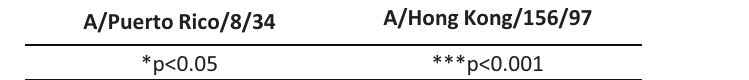
FIGURE 4 | Similar IgG1 titers found but different mFc γ RIII activation. Serum taken 1 day prior to influenza challenge were tested in ELISA for IgG1 binding to H1 FL HA A/Puerto Rico/8/34 (A) and for Fc γ RIII activation by H1 A/Puerto Rico/8/34 and H5 A/Hong Kong/156/97 in a surrogate ADCC assay (B) . Mouse samples